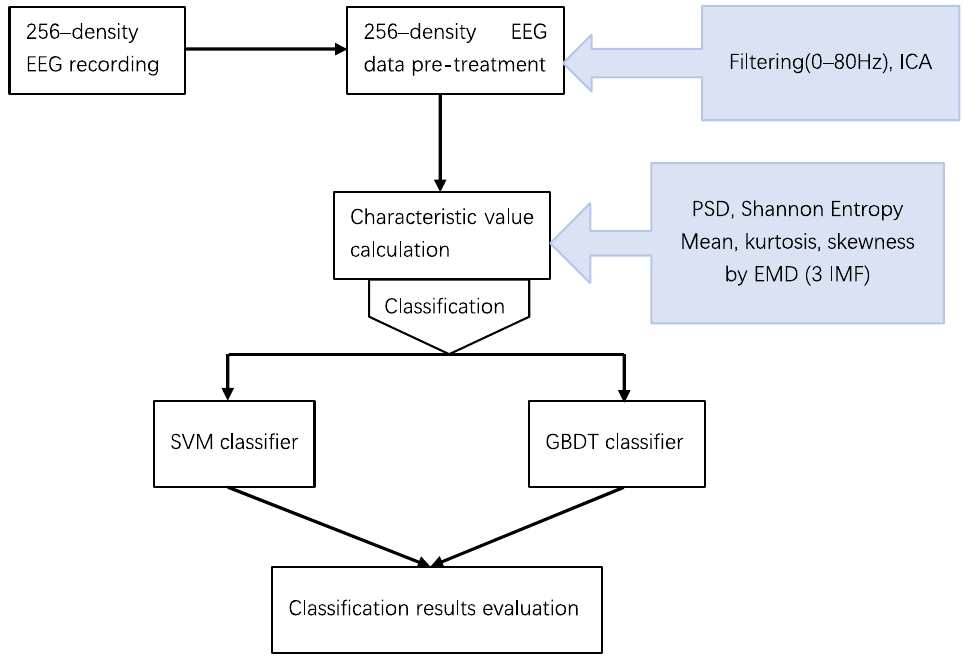
Figure 1. The technology roadmap of this